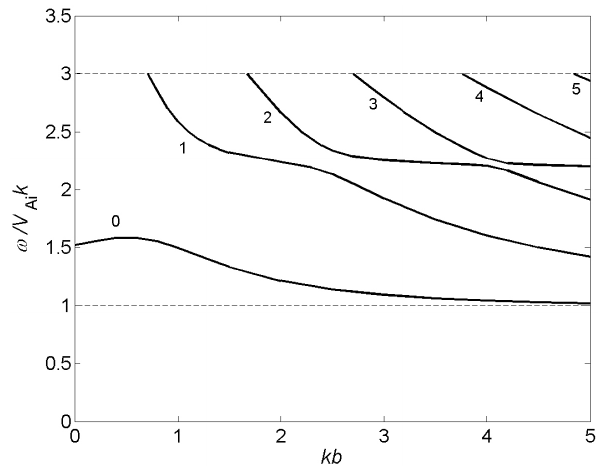
Figure 2. The dispersion curves for fast sausage waves in the com- plex current-carrying loop with a/b = 2 and V A